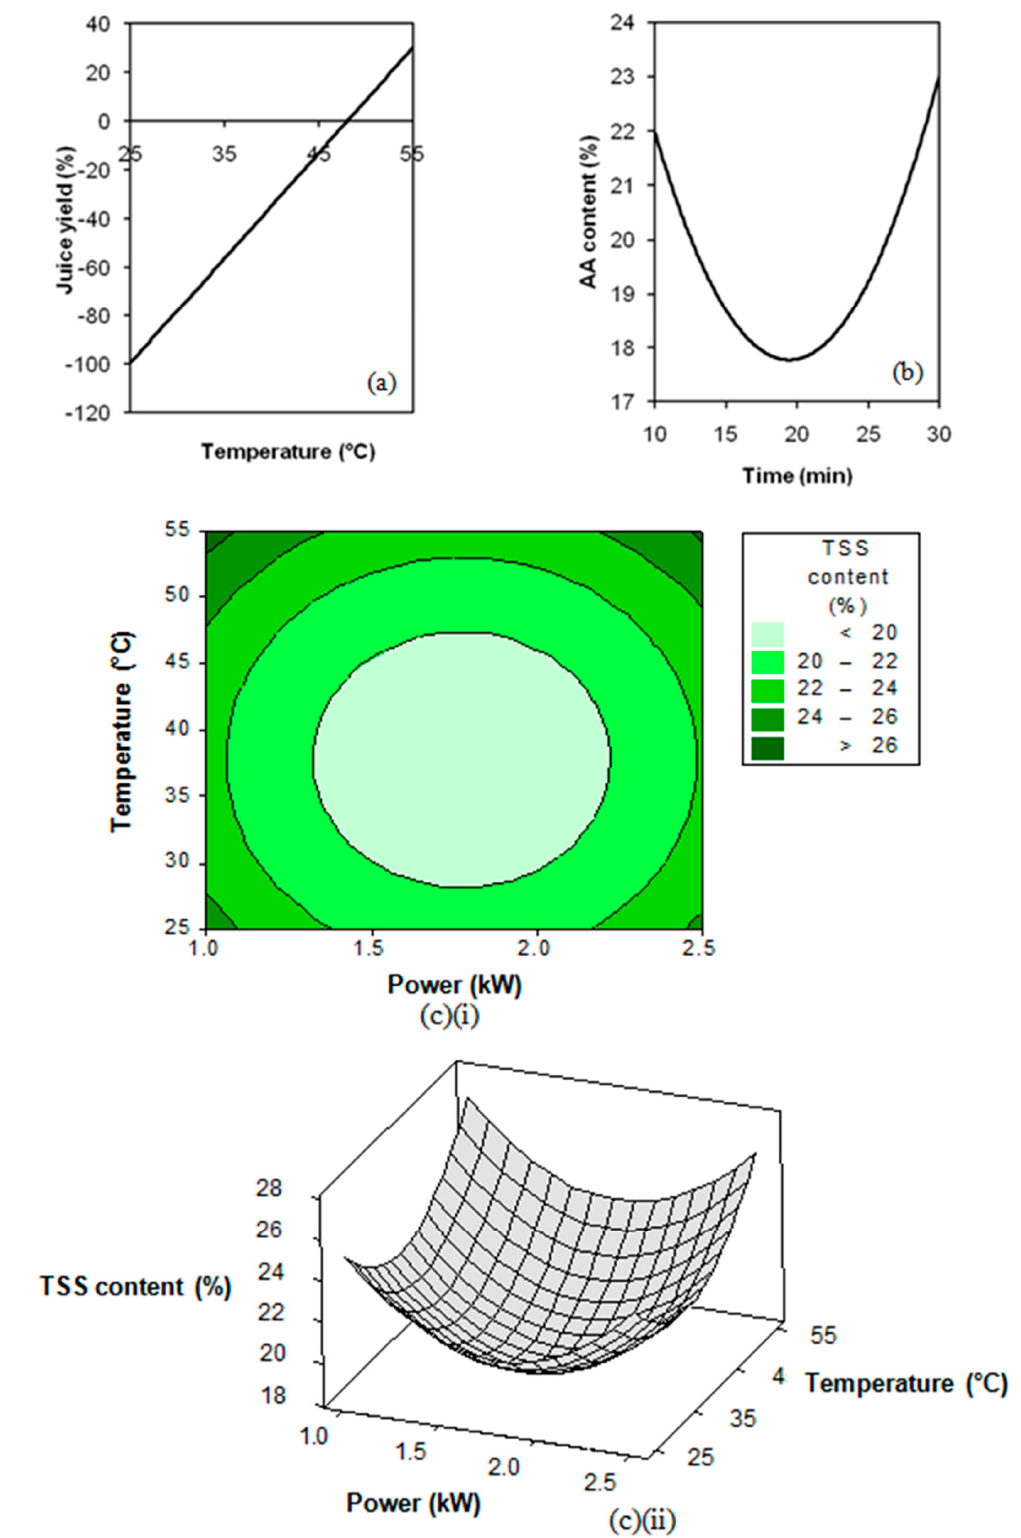
Figure 3. Plots of indirect thermosonication-assisted guava juice extraction responses. ( a ) Main effect plot of juice yield, ( b ) Main effect plot of AA content, ( c ) (i) 3D contour plot and (ii) 3D surface plot of TSS content.